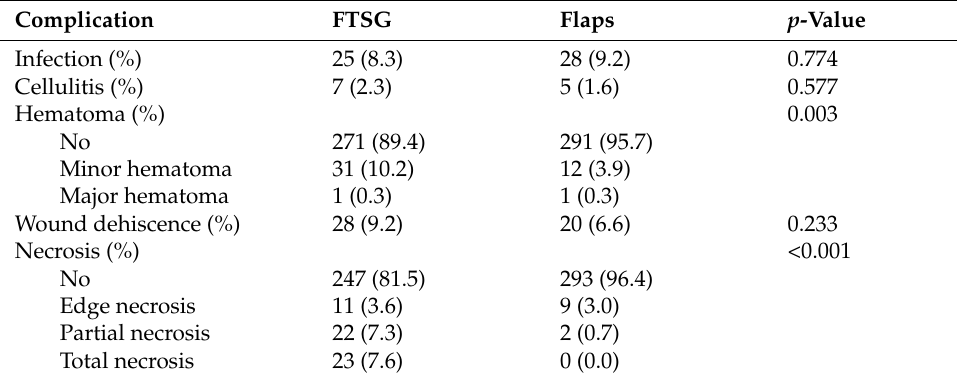
Table 4. Complications related to FTSGs and local flaps.